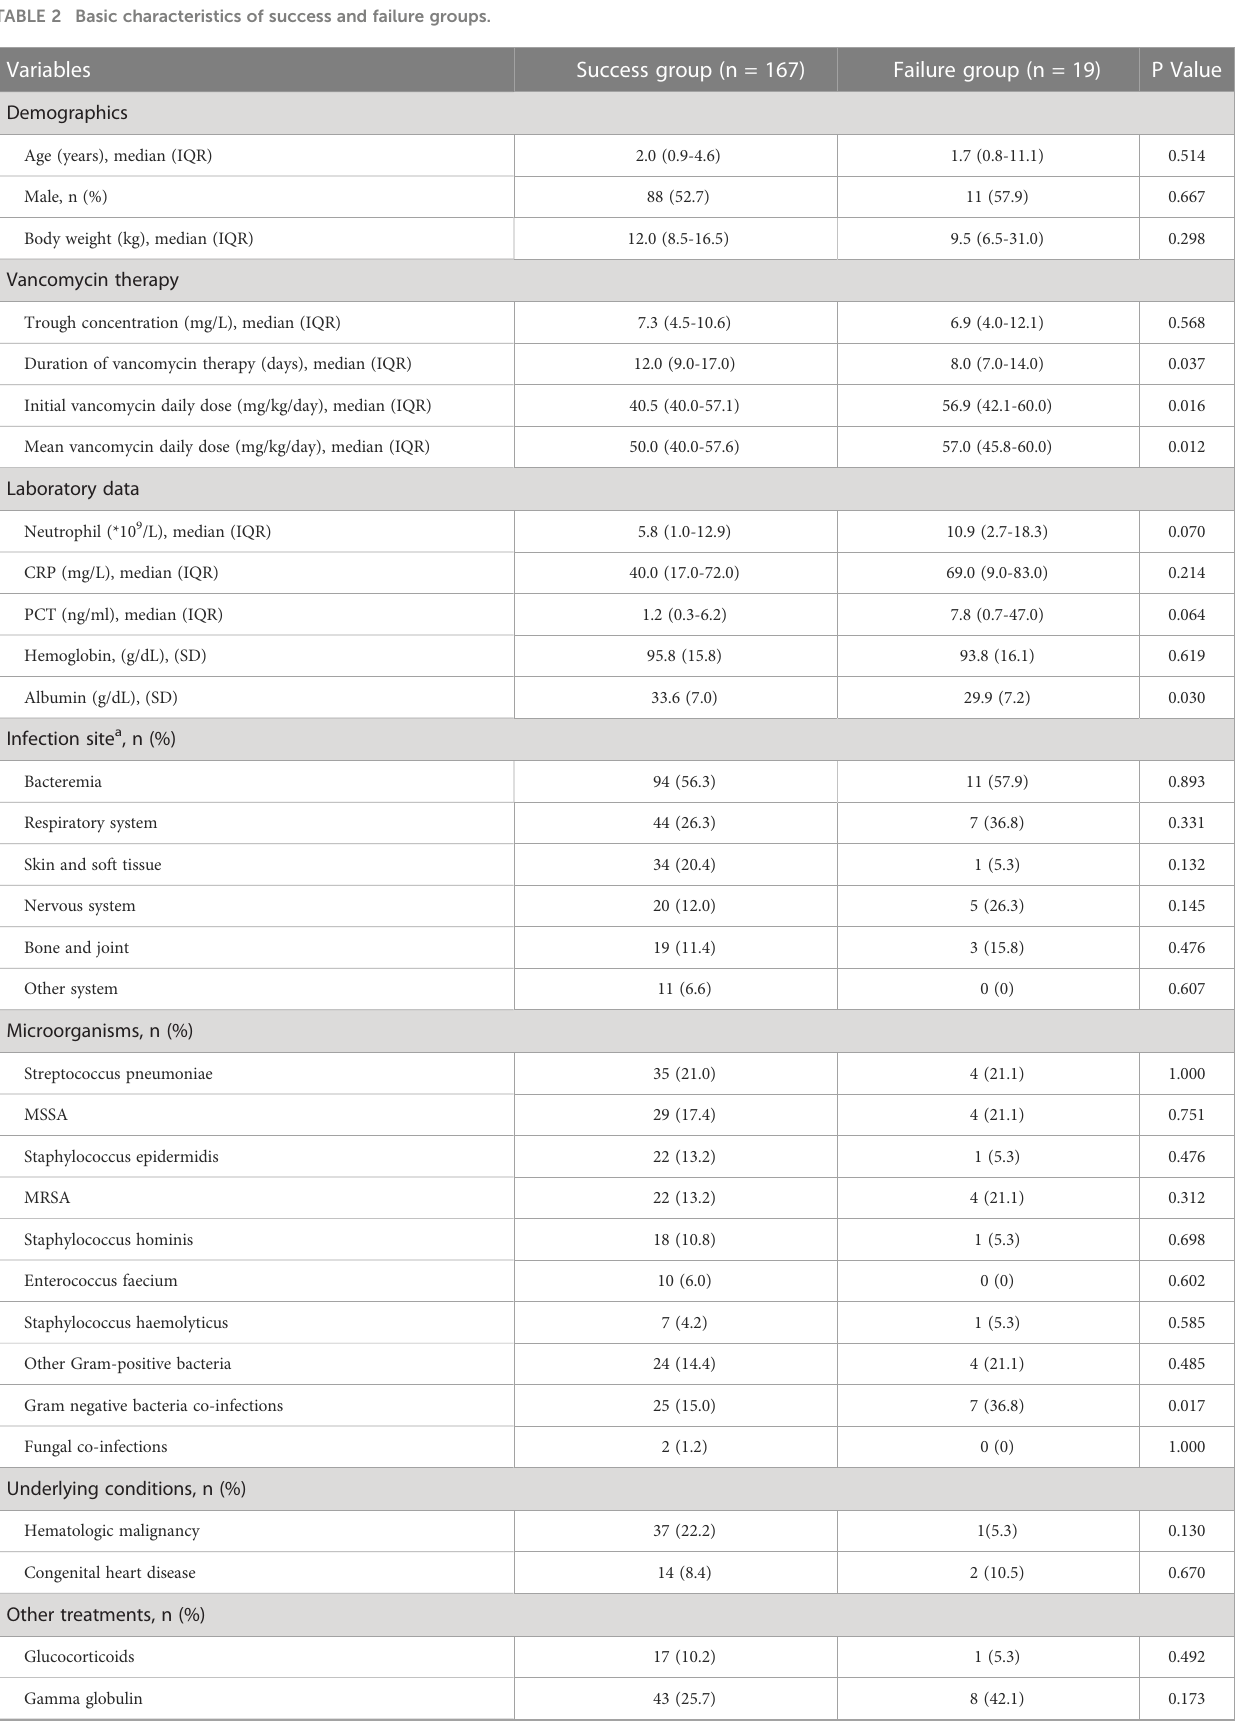
TABLE 2 Basic characteristics of success and failure